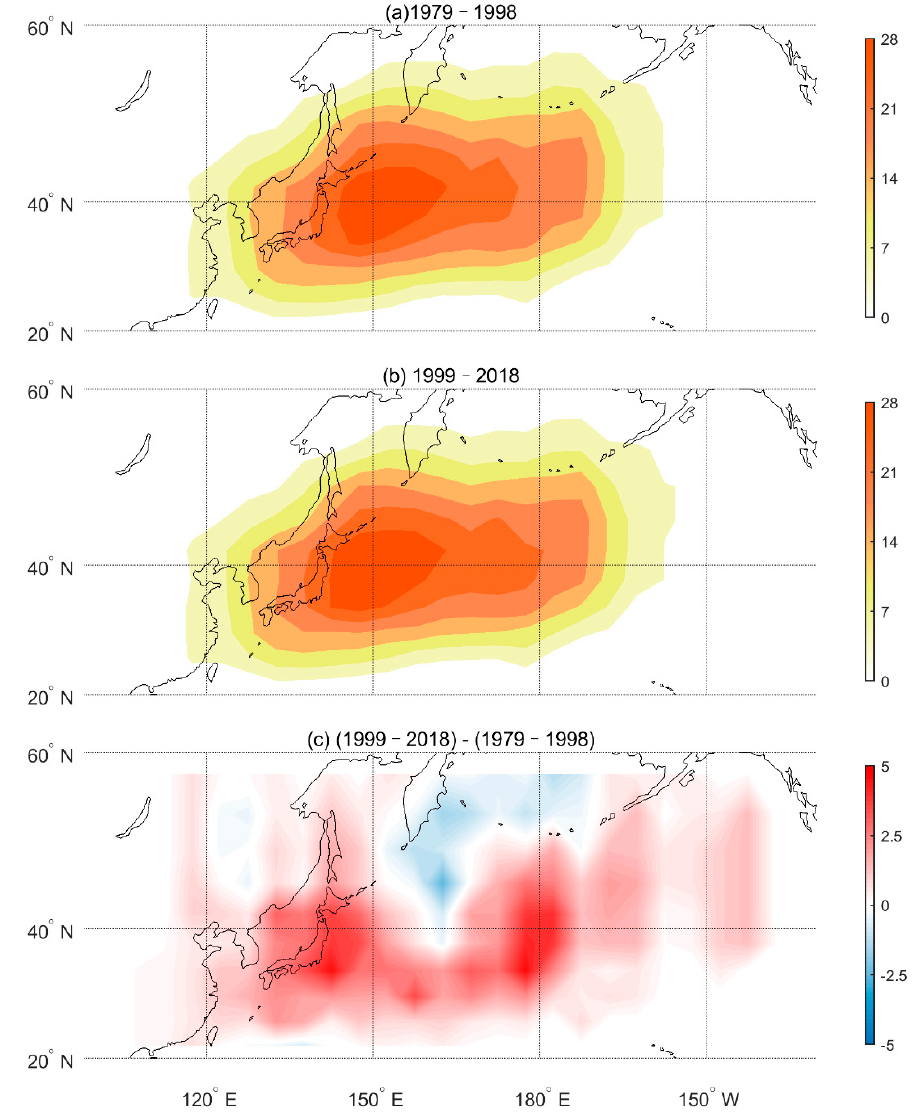
Figure 2. ( a , b ) Extratropical cyclone (ETC) track density over the Northwest Pacific from 1979 to 2018, Unit: cyclones per winter per grid. ( a ) For the period 1979–1998, ( b ) period 1999–2018, and ( c ) the difference between the earlier period (1979–1998) and later period (1999–2018). Grids with values statistically significant at the 95% level are indicated by the symbol “+”.